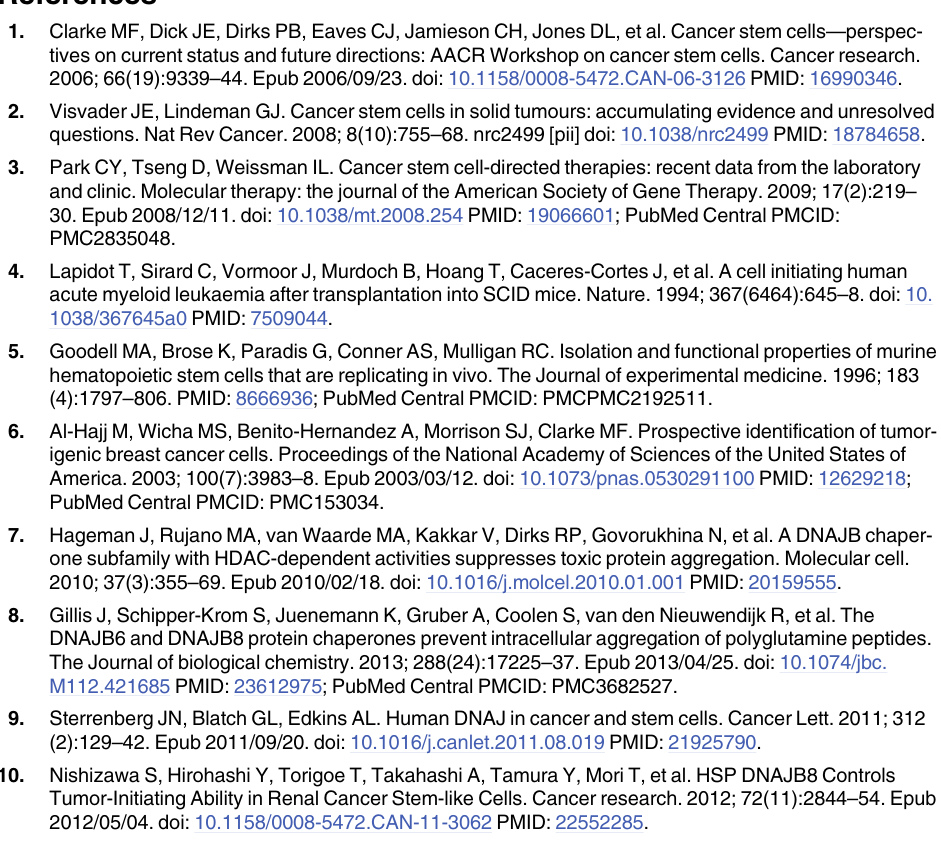
S1 Fig. RT-PCR of stem cell-related genes. The expressions of stem cell related genes ( Sox2 , Nanog , Klf4 , Bmi1 ) were addressed by RT-PCR. Gapdh was used as an internal positive con- trol. (TIF) S2 Fig. Transfection of Ataxin-3 T-Q82 gene. RenCa, Dnajb8 overexpressed RenCa (RenCa/ Dnajb8), Dnajb8 KO cells (RenCa/Dnajb8 KO #1 – 2 and #4 – 1) cells were transfected with Ataxin-3 T-Q82 gene fused with GFP protein. The overexpressed Ataxin-3 T-Q82/GFP protein were visualized by confocal laser microscopy. DAPI was used for nuclear staining.